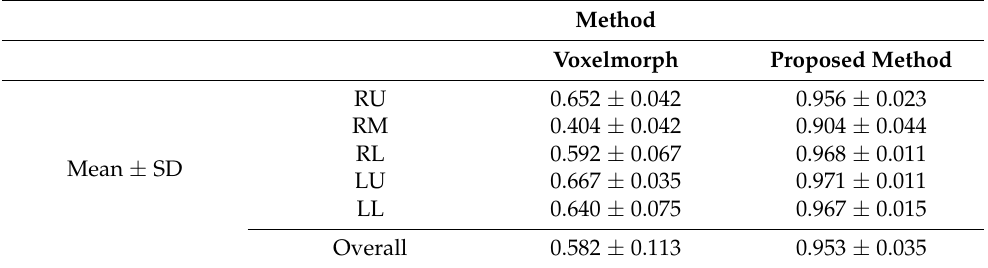
Table 2. Quantitative summary of the direct application of Voxelmorph and the proposed